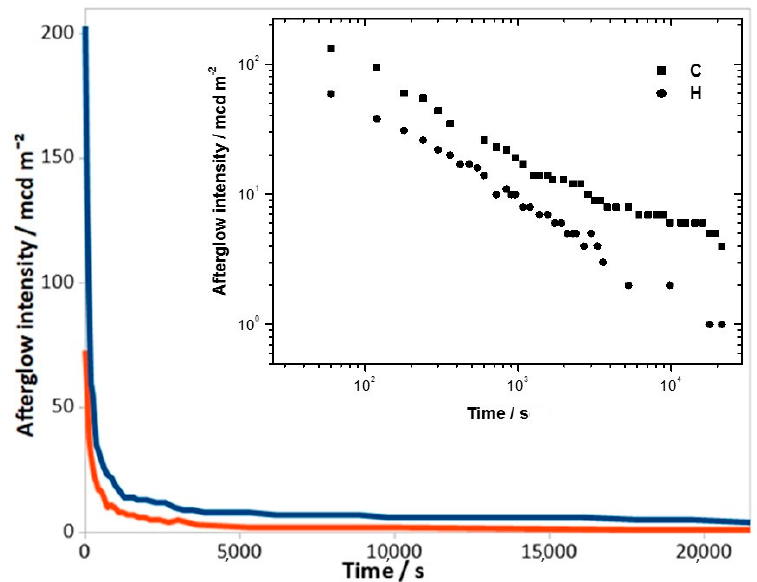
Figure 3. Decay curves of samples C (blue) and H (red). The upper inset showed the log-log plot.